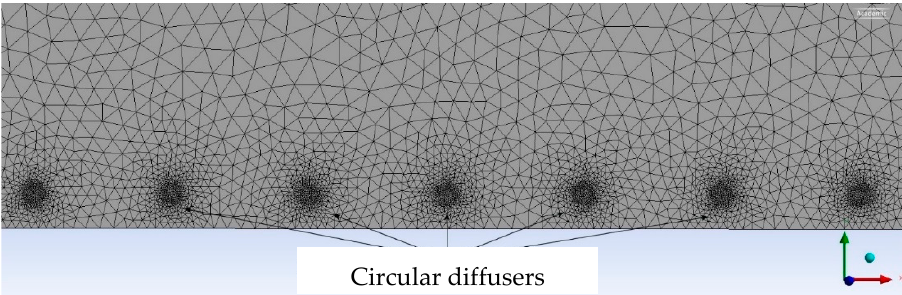
Figure 10. Refined mesh near the circular diffusers of the station ventilation system.